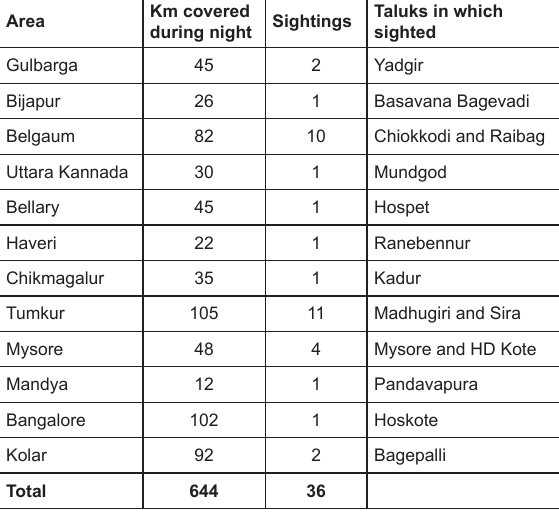
Table 2. Sight records of the Indian fox in different drier regions of the Karnataka Km covered Taluks in which Area Sightings during night